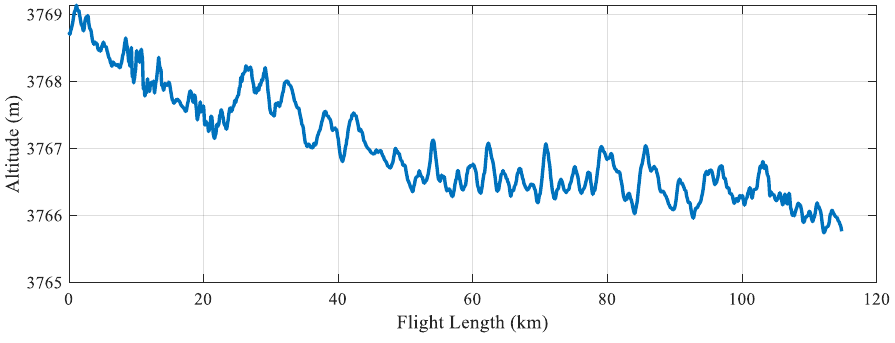
Figure 4. The variation of altitude along the flight path.